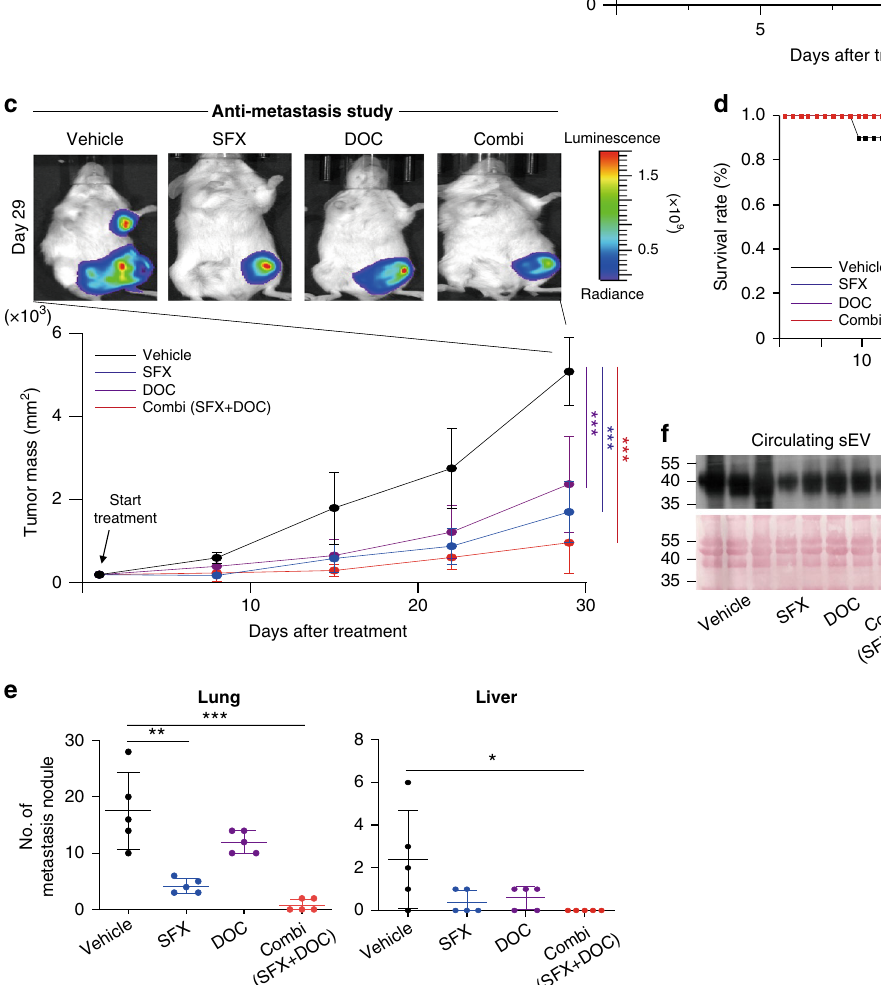
determined the amounts of circulating human cancer cells- derived sEV in the sera of host mice by using the speci fi c antibody recognizing the human CD63 but not the mouse CD63 (ref. 12 ). Densitometric analysis revealed that the expression of human CD63 exosomal protein was signi fi cantly decreased in the SFX- treated animals and DOC-combination group compared to vehicle-exposed controls (Fig. 2f). To further validate whether the anti-cancer effect of SFX is mediated through the inhibition